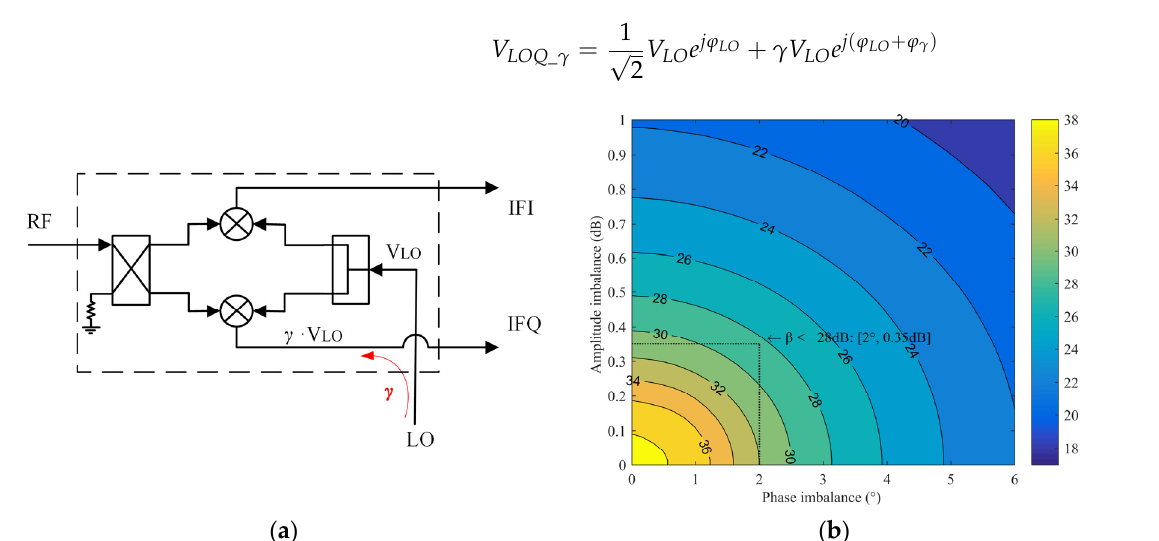
Figure 7. ( a ) Analysis of the influence of coupling 𝛾 on the imbalance; ( b ) Amplitude and phase imbalance caused by the coupling 𝛾 .